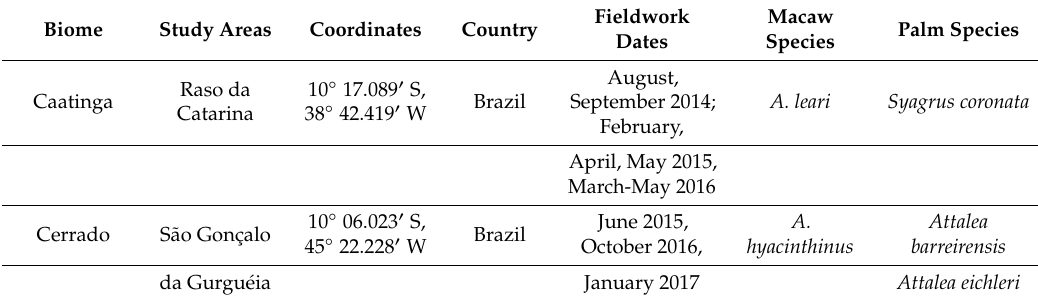
Table 1. Location of study areas, fieldwork dates, and the macaw and palm species present therein.